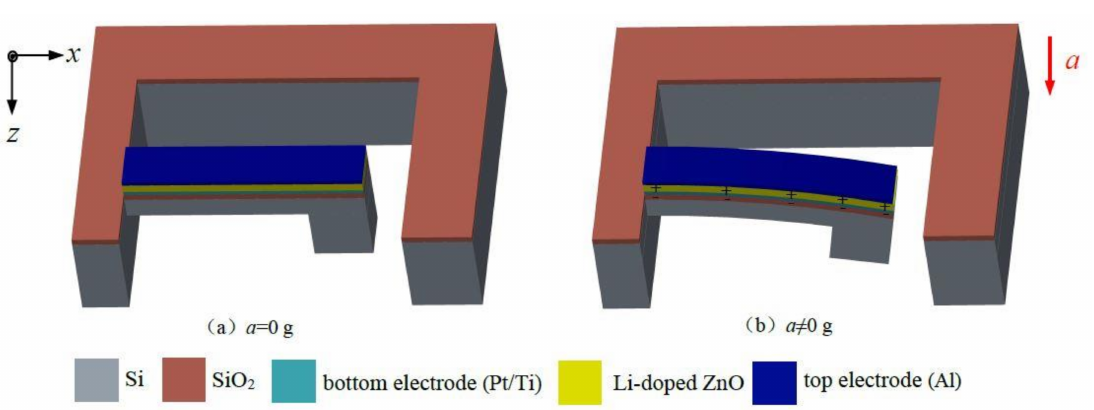
Figure 2. The operating principle of the Li-doped ZnO piezoelectric thin films acceleration